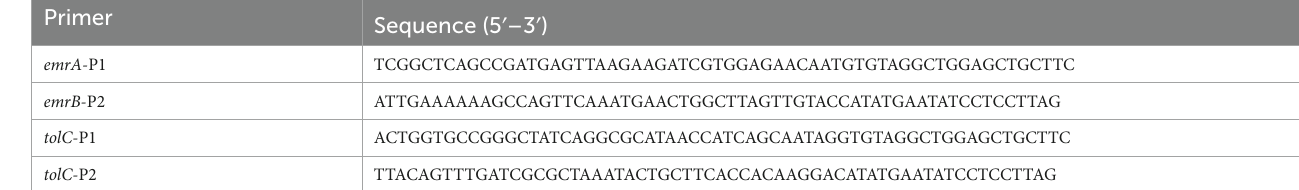
TABLE 2 Primers used in this study. Primer Sequence (5